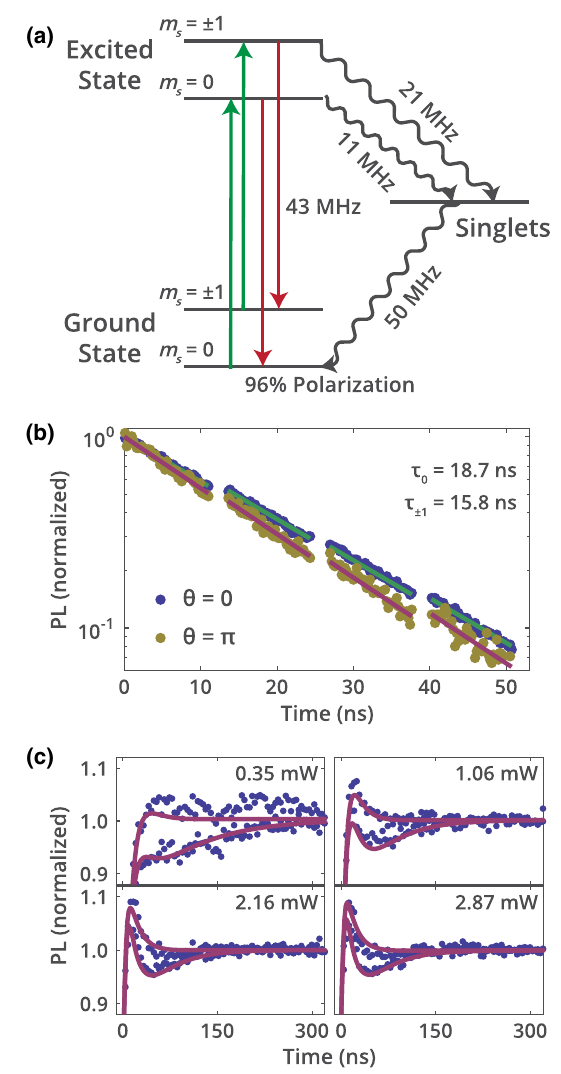
FIG. 4. Dynamicalmodelofthe3C-SiCdivacancy.(a)Diagramof the levels and major rates in the five-level rate-equation model. The transition rates and ground-state spin polarization are inferred from the global fit described in the main text. (b) Normalized log plot of the fluorescence recorded on a single 3C-SiC divacancy. The θ ¼ 0 data are the time-resolved PL when no microwaves are applied and ¼ 0 , while the θ ¼ π data are taken after a the spin remains in m s ¼ − 1 state.Thesmall microwave π pulsepreparesthespininthe m s gaps originate from a preprocessing step where small pulses imperfectly extinguished by our electro-optic modulator are re- moved. (c) Normalized single divacancy photoluminescence emit- ted at the beginningoff-resonant cw laser pulses of different powers. Theupper trace in each subpanel is the PL observed when the spin is ¼ 0 , while the respective lower traces are observed prepared in m s ¼ − 1 .Solidlines whena microwave π pulse rotatesthespininto m s are the corresponding global fits of the rate-equation